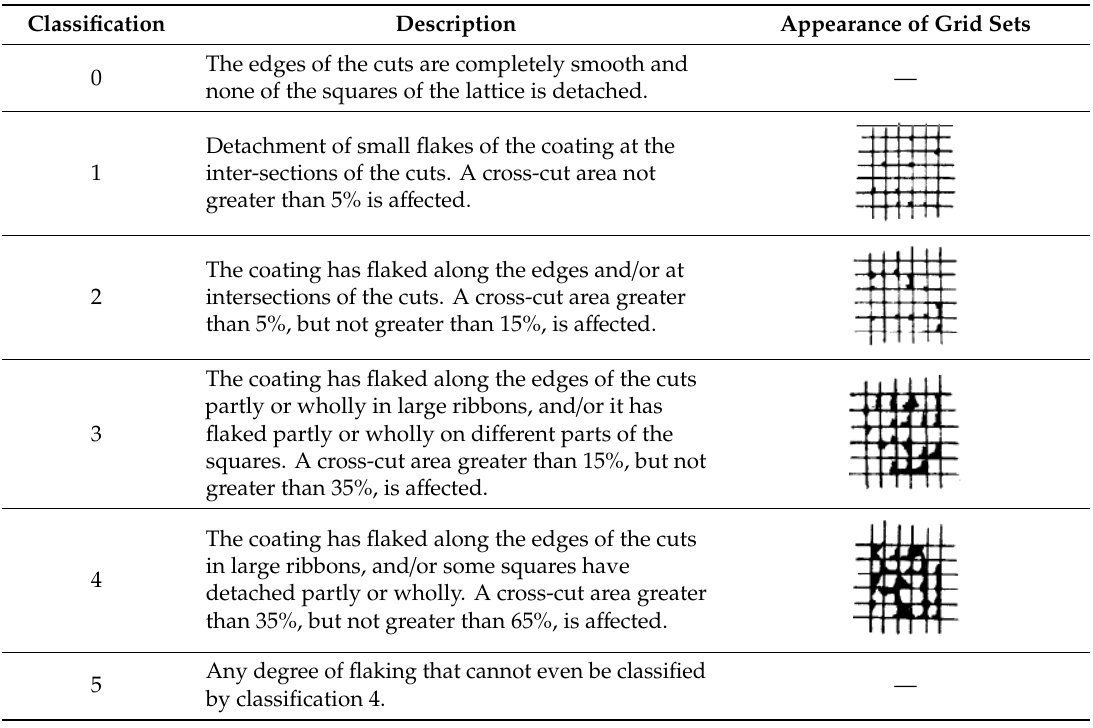
Table 1. Evaluation criterion according to ISO 2409.